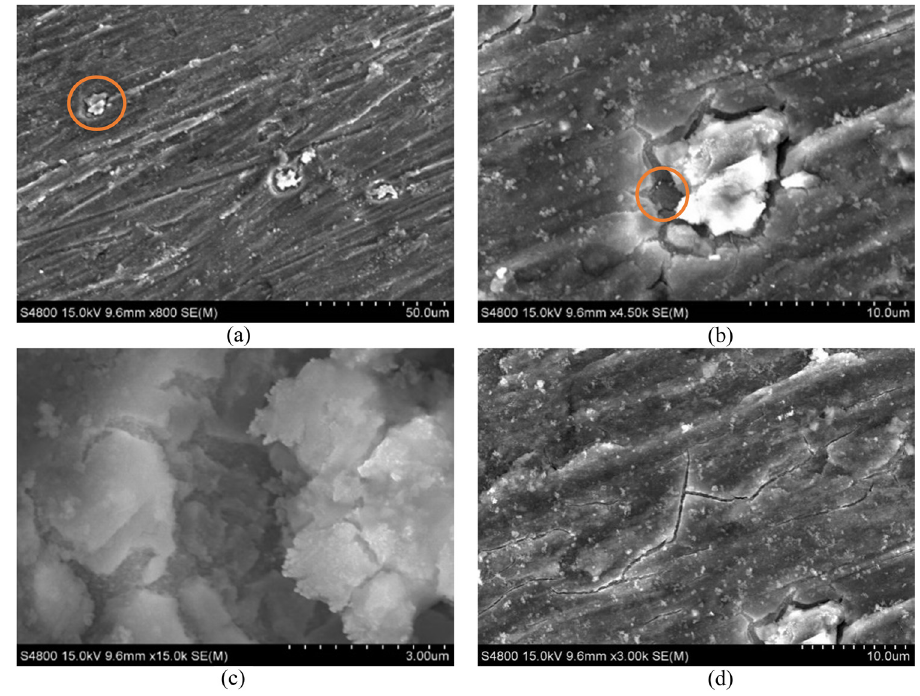
Figure 18: SEM micrograph of aluminium alloy corroded by saturated Ca ( OH ) 2 solution: ( a ) 192 × , ( b ) 960 × , ( c ) 3,200 × , and ( d ) 960 ×